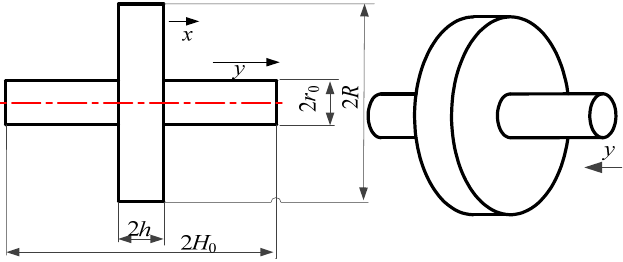
Figure 5. Simplified model of energy concentrating structure.